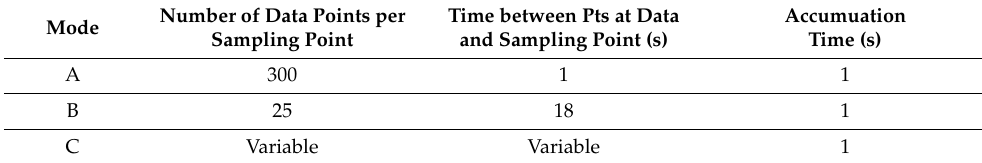
Table 1. Operational modes of the multi-window mould.